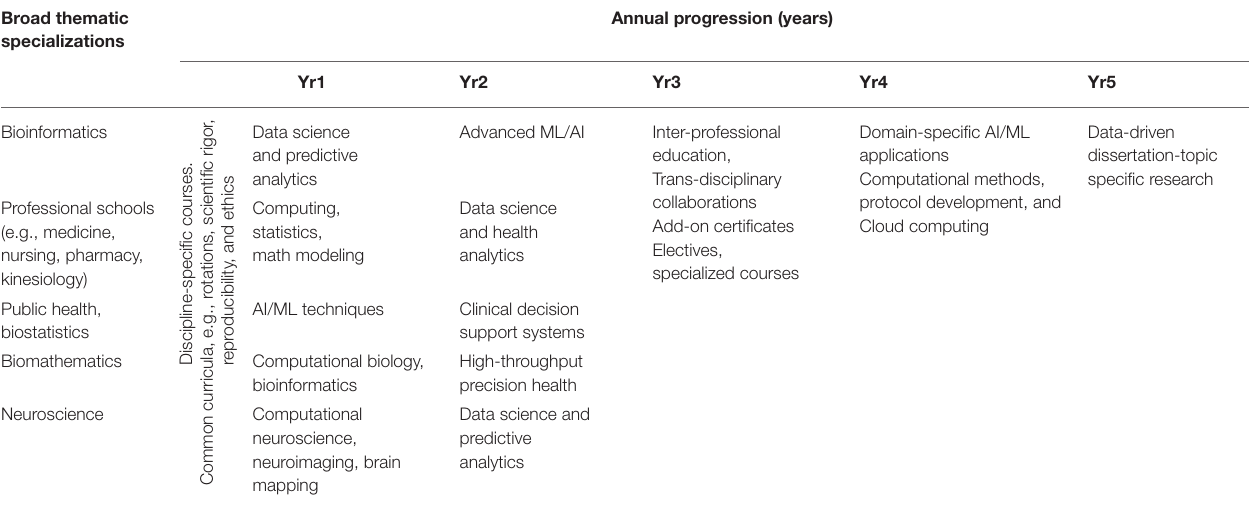
TABLE 3 | Examples of hypothetical broad-scope 5-year program plans by